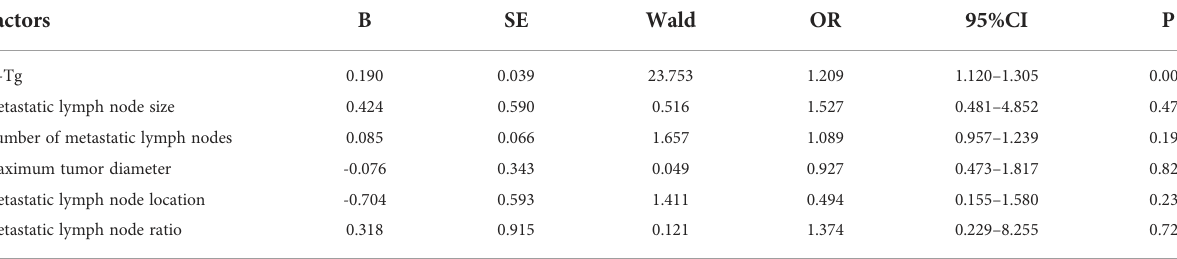
TABLE 2 Results of multifactorial logistic regression analysis affecting ER in patients with intermediate-risk